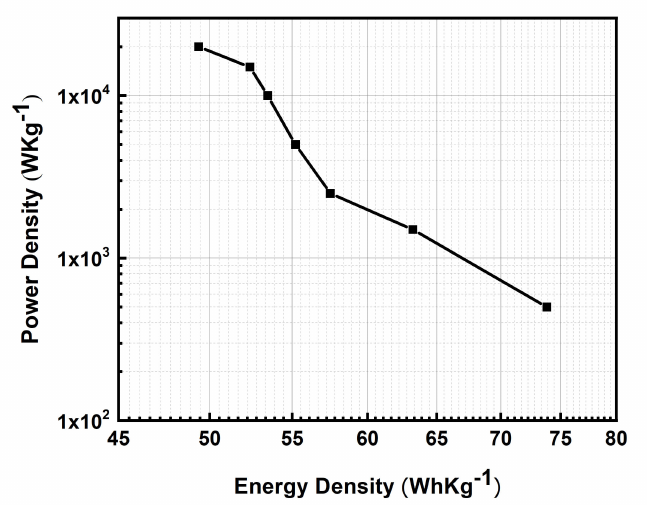
Figure 11. Ragone plot of the FTO-PANI supercapacitor for current densities between 1 Ag − 1 (top left side) to 40 Ag − 1 (bottom right